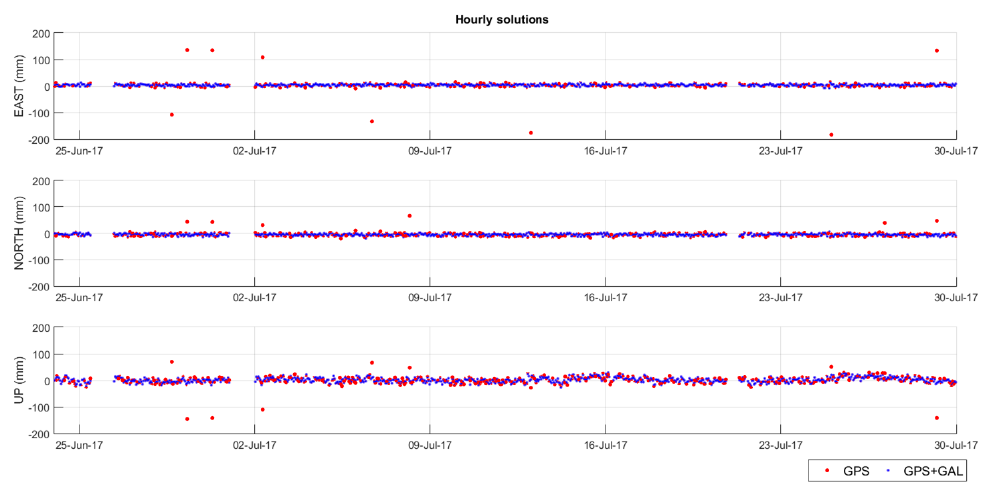
Figure 3. Hourly estimates of the coordinates of a point on a bridge: red dots are GPS-only solutions; blue dots are GPS and Galileo joint solutions. Outliers are quite